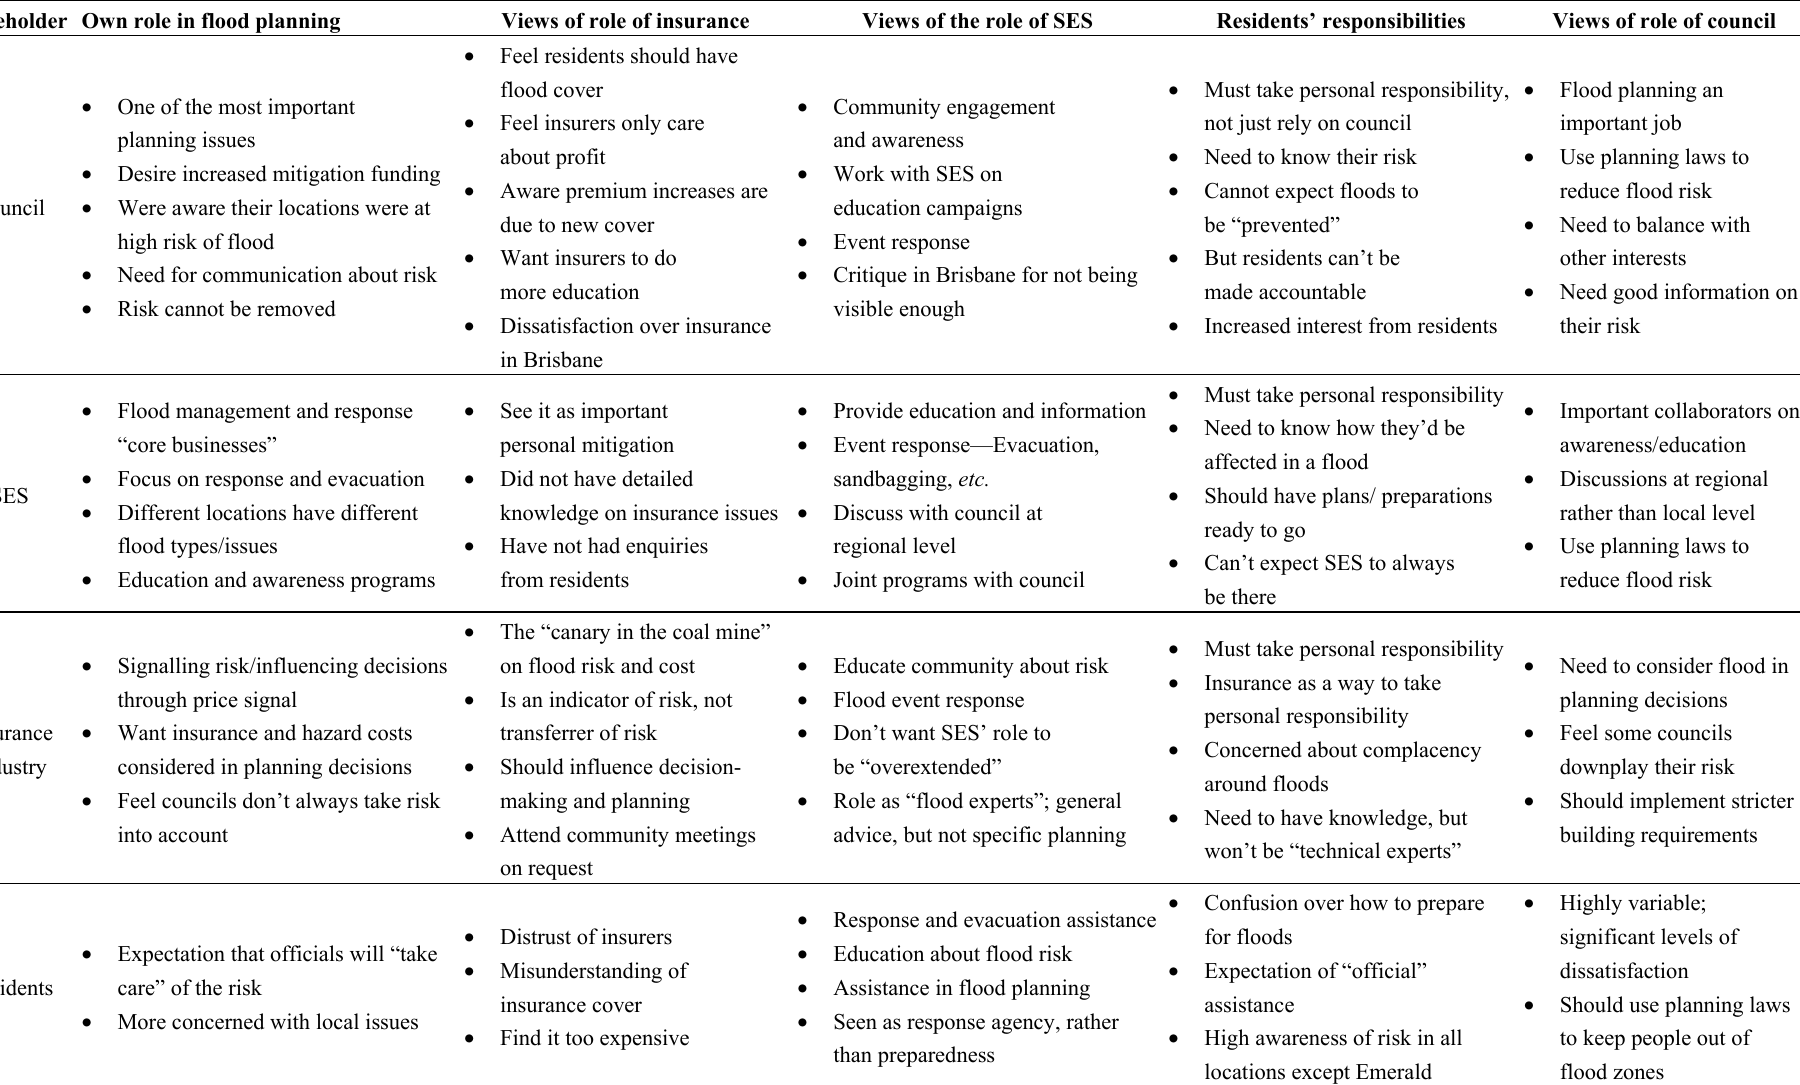
Table 2. Perceptions of roles and